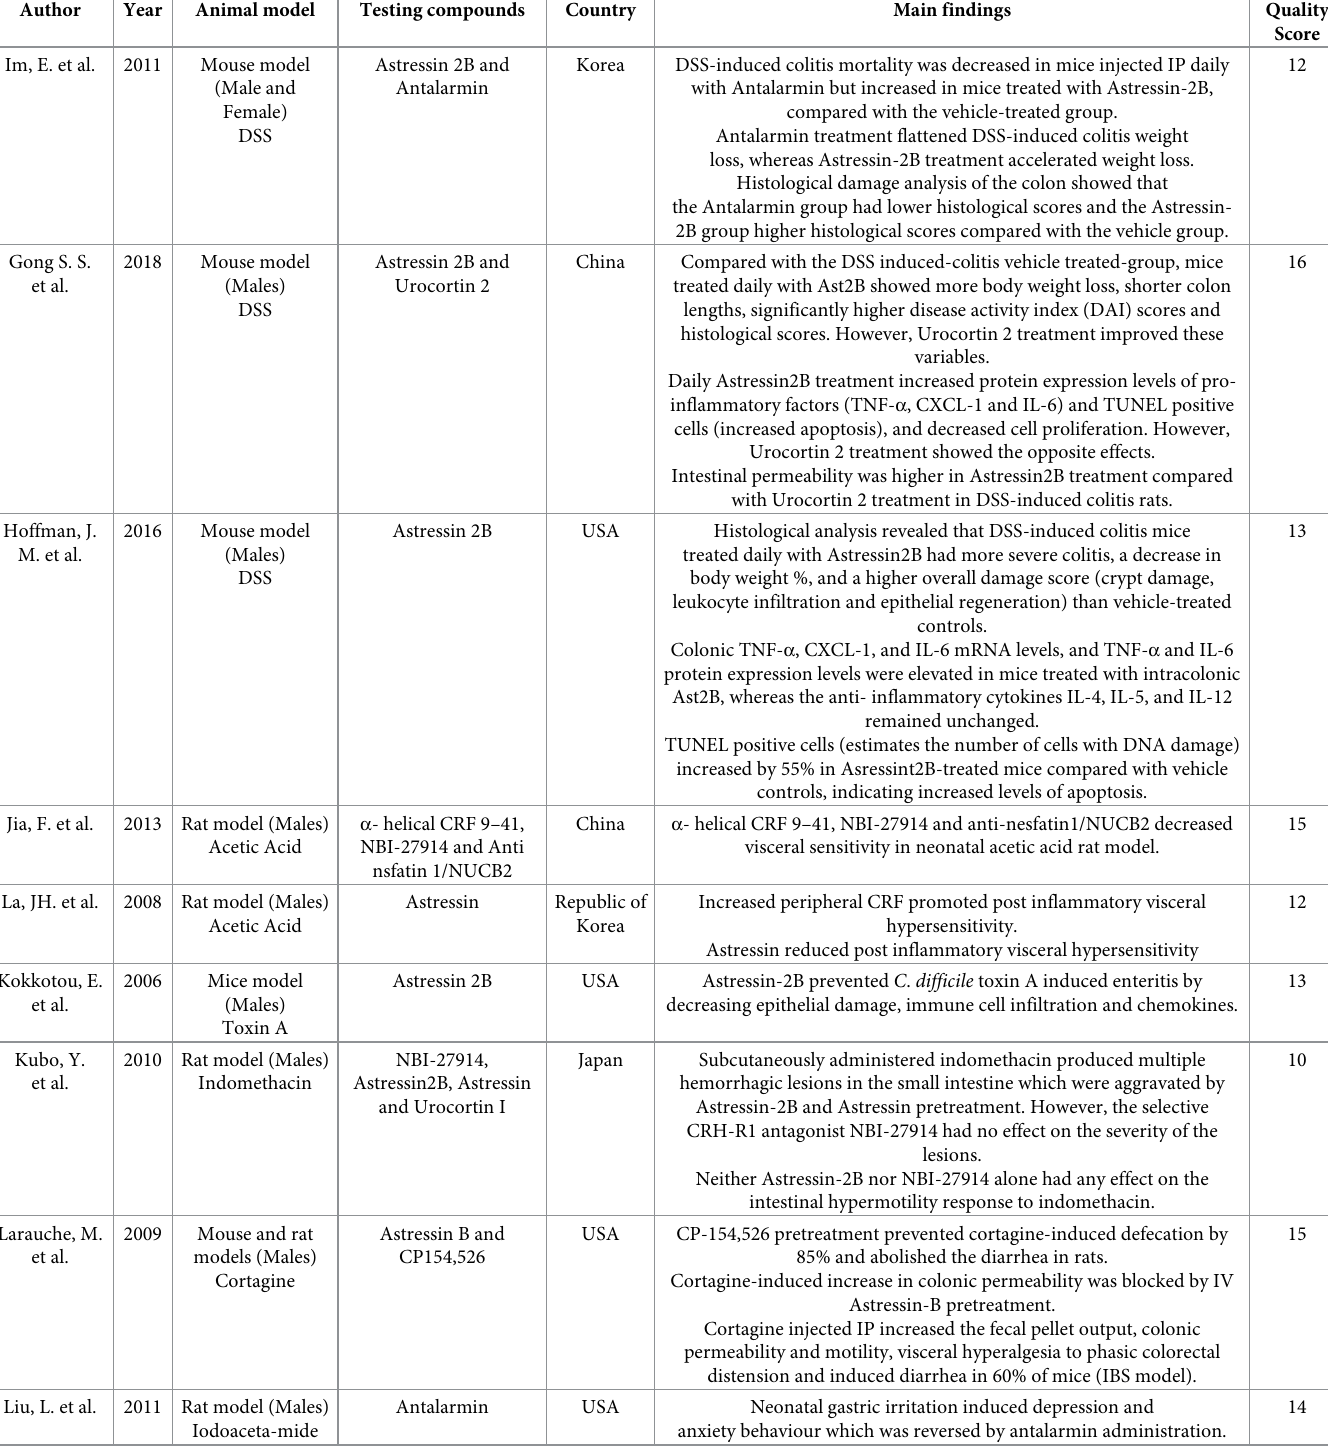
Table 3. Chemical